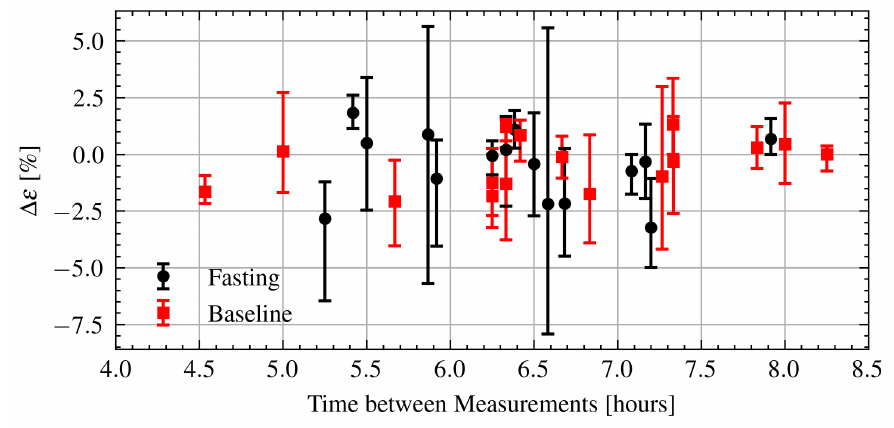
Figure 13. Estimated change in permittivity over time of fasting and baseline volunteers. Dots are measurement session medians and error bars are minimum and maximum values.